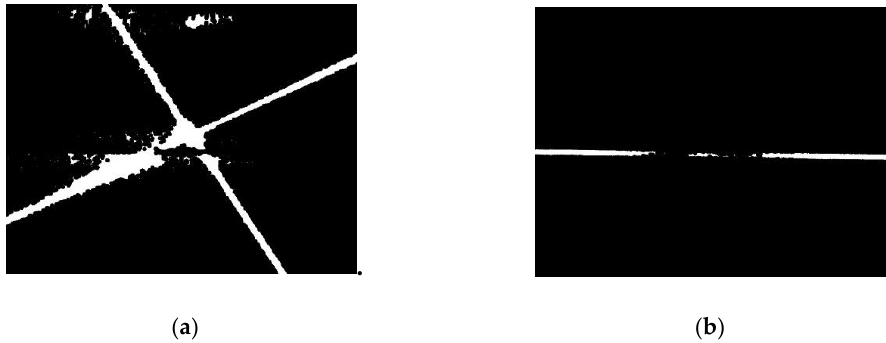
Figure 6. ROI after close operation. ( a ) Laser stripe region. ( b ) Joint region.